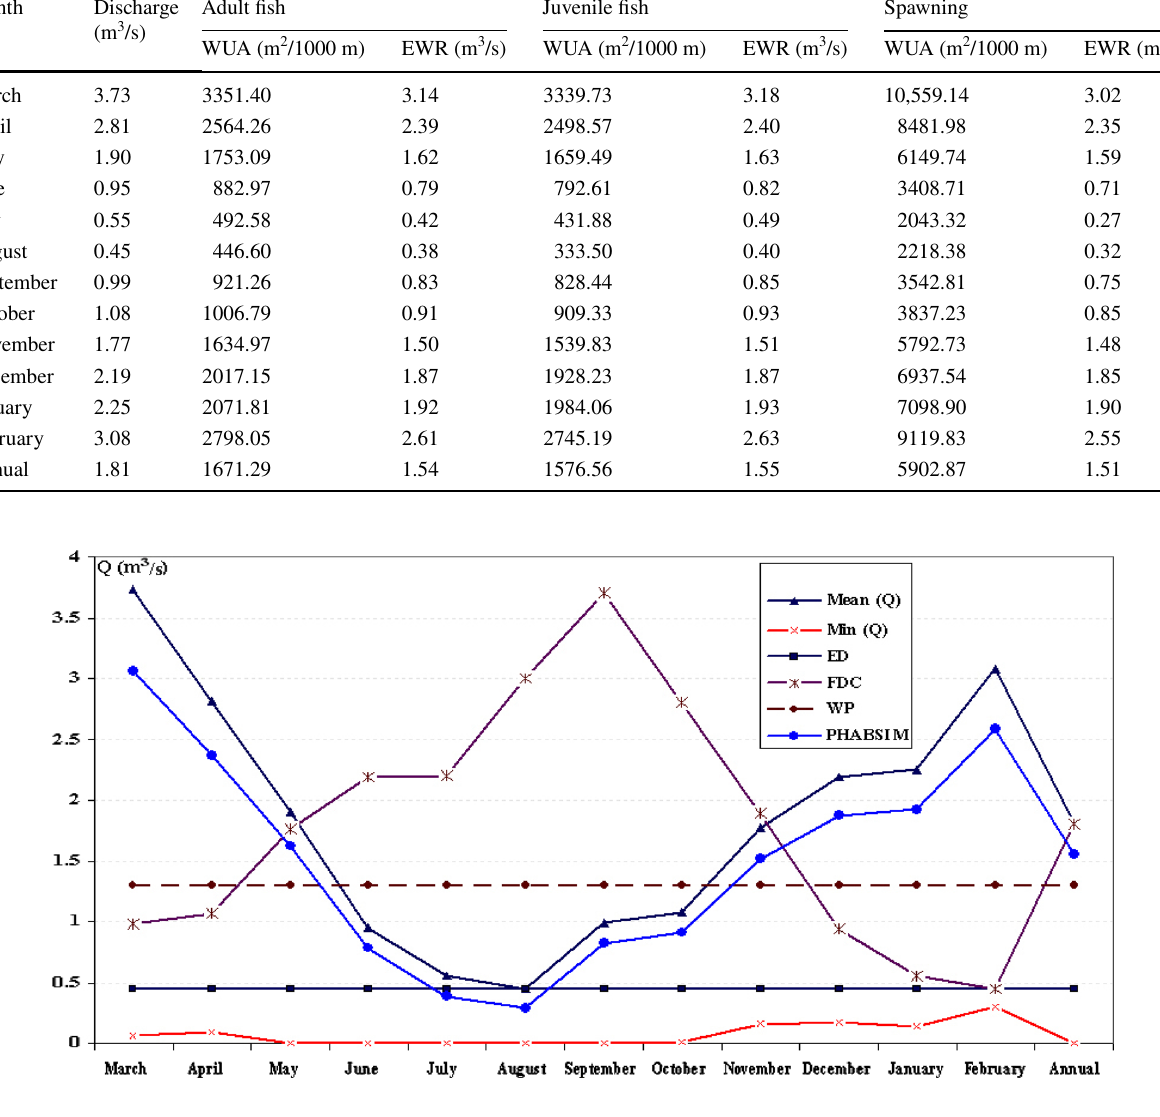
method; FDC FDC method, WP the Wetted-Perimeter method (EWR changes from 0.22 to 35 in the different sections and the mean is 1.3); PHABSIM